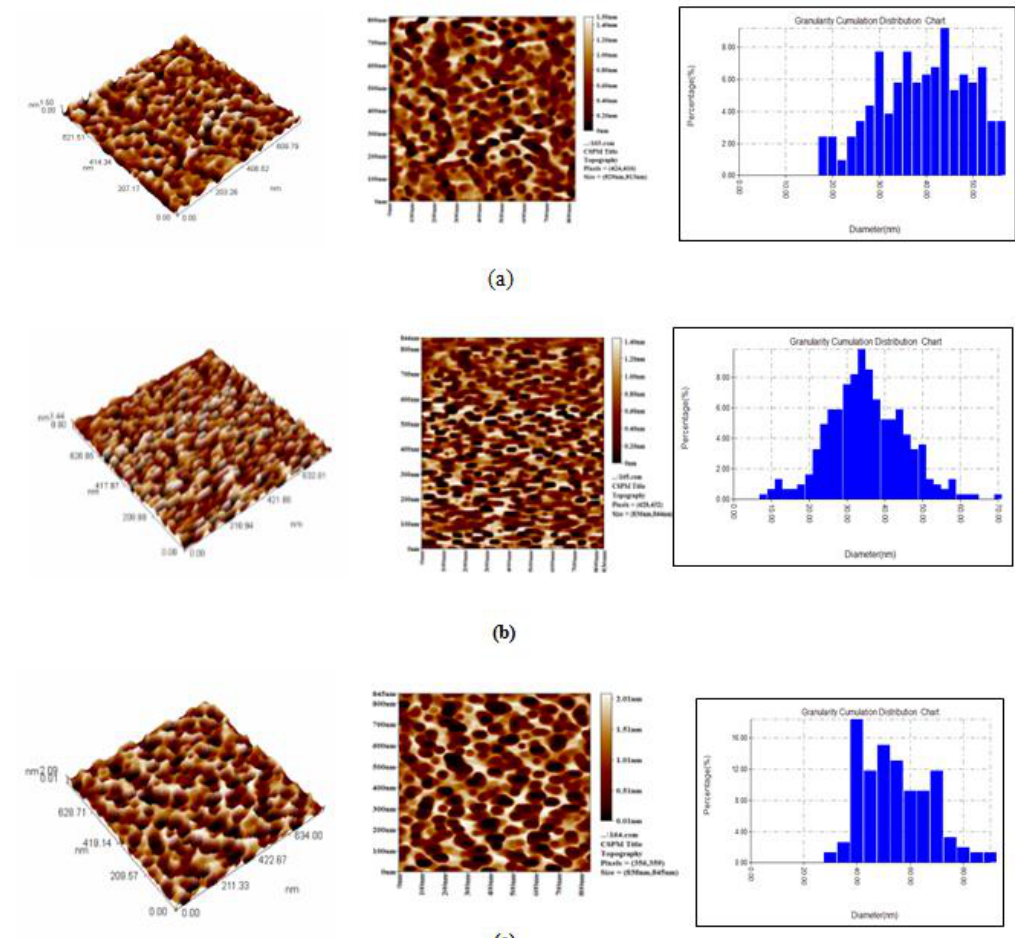
Fig.3: 2D, 3D AFM images and size distribution diagrams of meso - porous silicon (p-type) prepared at different current densities; (a) 10, (b) 20, (c) 40 mA/cm 2